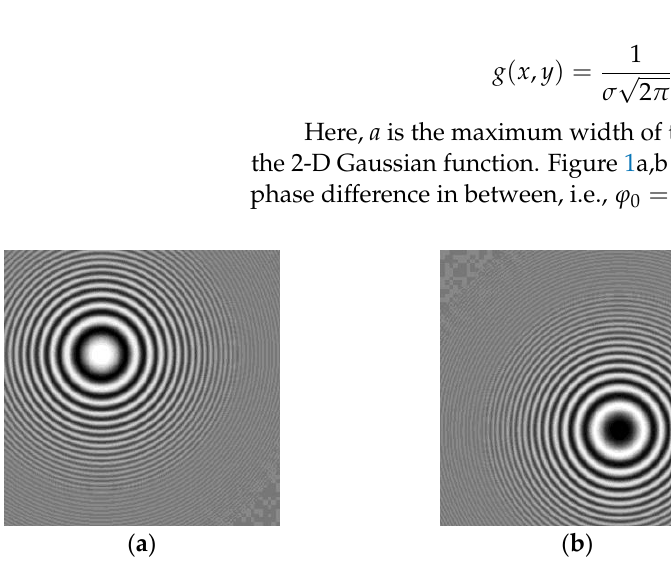
Figure 1. Gaussian-based circular fringe patterns: ( a ) a 2-D fringe pattern; ( b ) the fringe pattern with 180 ◦ phase difference from ( a ) at a different location; ( c ) the fringe pattern which is the mixture of ( a , b ).